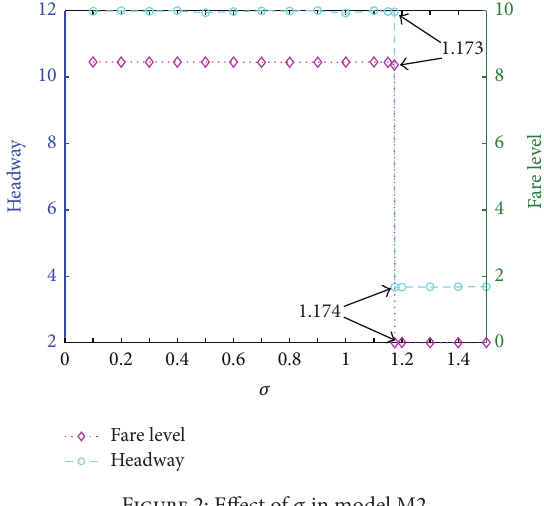
Figure 2: Effect of 𝜎 in model M2.